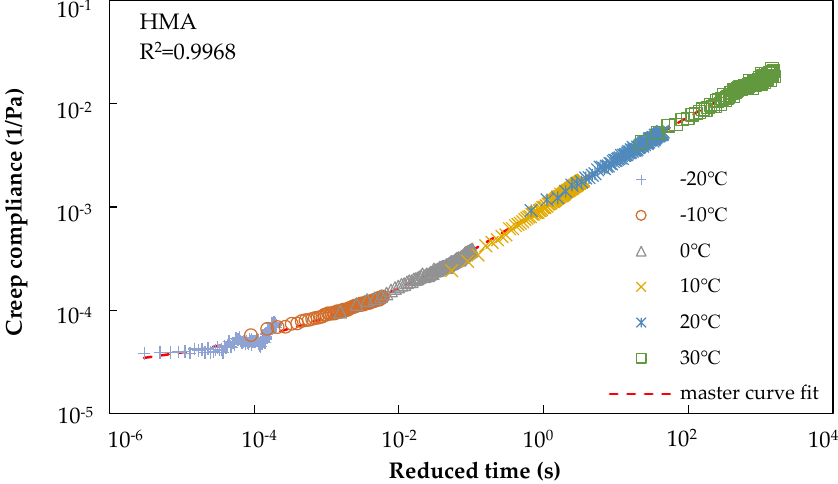
Figure 3. Master curve fits to experimental data at reference temperature of 21.1 °C for creep compliance.